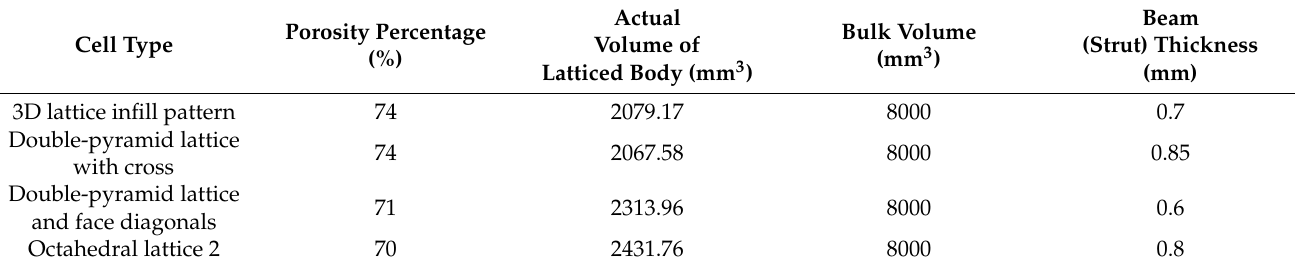
Table 3. The parameters of the